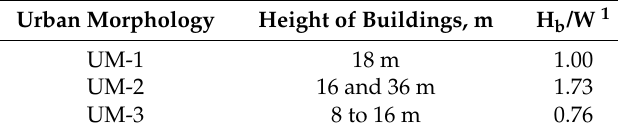
Table 1. Height of buildings and its ratio to street width for selected urban